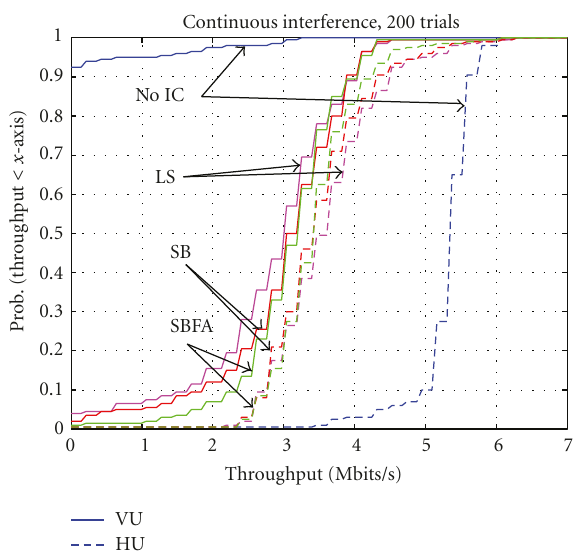
Figure 14: Throughput CDF for residential scenario of Figure 12 and a continuous intersystem